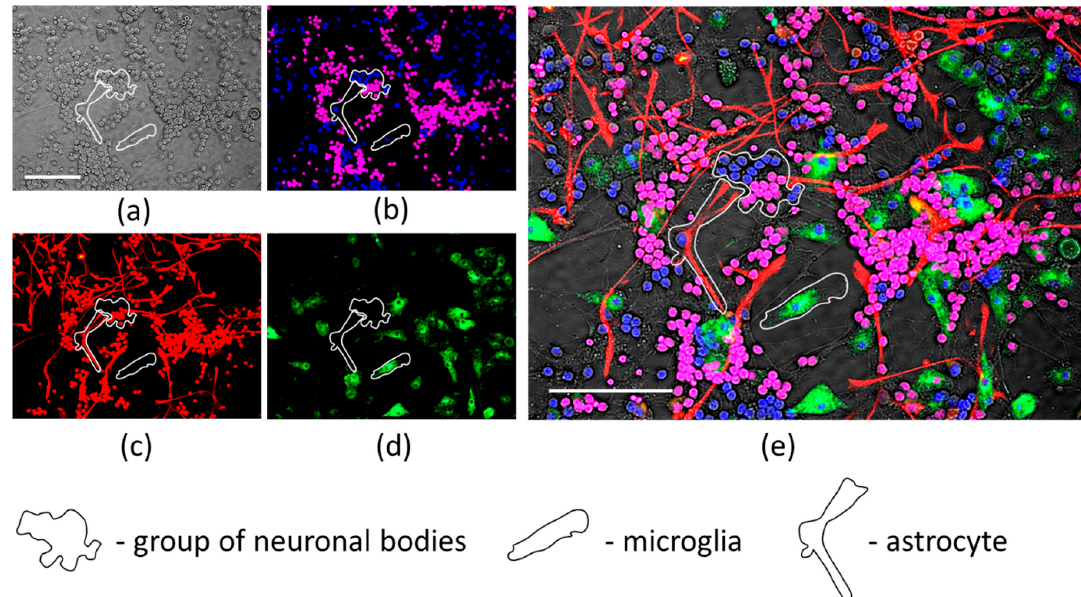
Figure 3. The identification of cells with necrotic nuclei in cell cultures after simultaneous hypoxia and DOG treatment. All panels represent the same microscopic field visualized under different filters or conditions. ( a )—brightfield phase contrast image; ( b )—Hoechst- and PI-positive nuclei under DAPI filter; ( c )—both PI-positive nuclei and GFAP-positive astrocytes under the TxRed filter set; ( d )—microglia visualized under the FITC filter set; ( e )—merged image. Typical representatives of each cell type are indicated by white shapes, as explained in the legend. Scale bar is 100 µm.